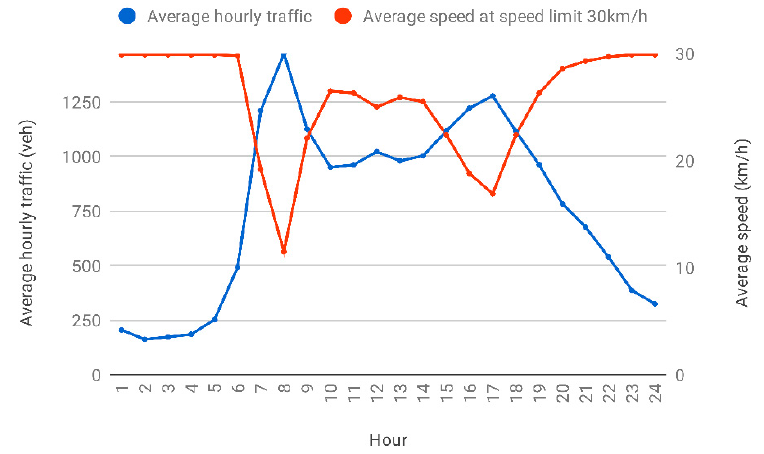
Figure 3. The average hourly traffic and average speed at the speed limit of 30 km/h at different hours of a day for all road segments across 2013.